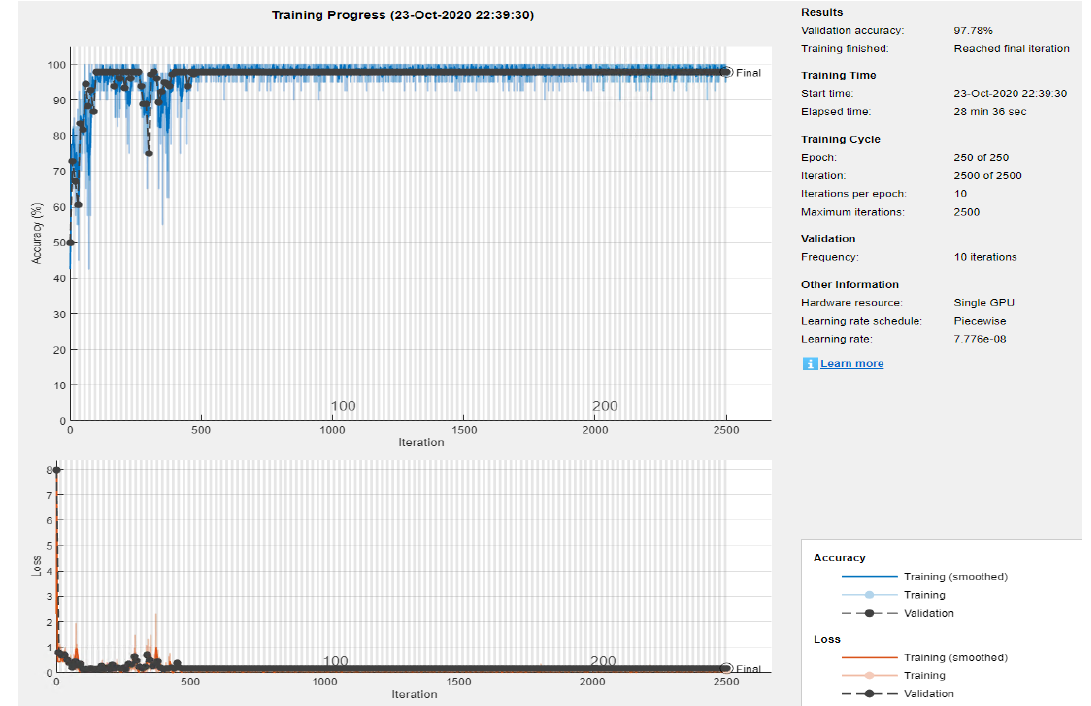
Figure 10. Experiment 2: Training and validation accuracy progress for two classes: Normal and Abnormal using